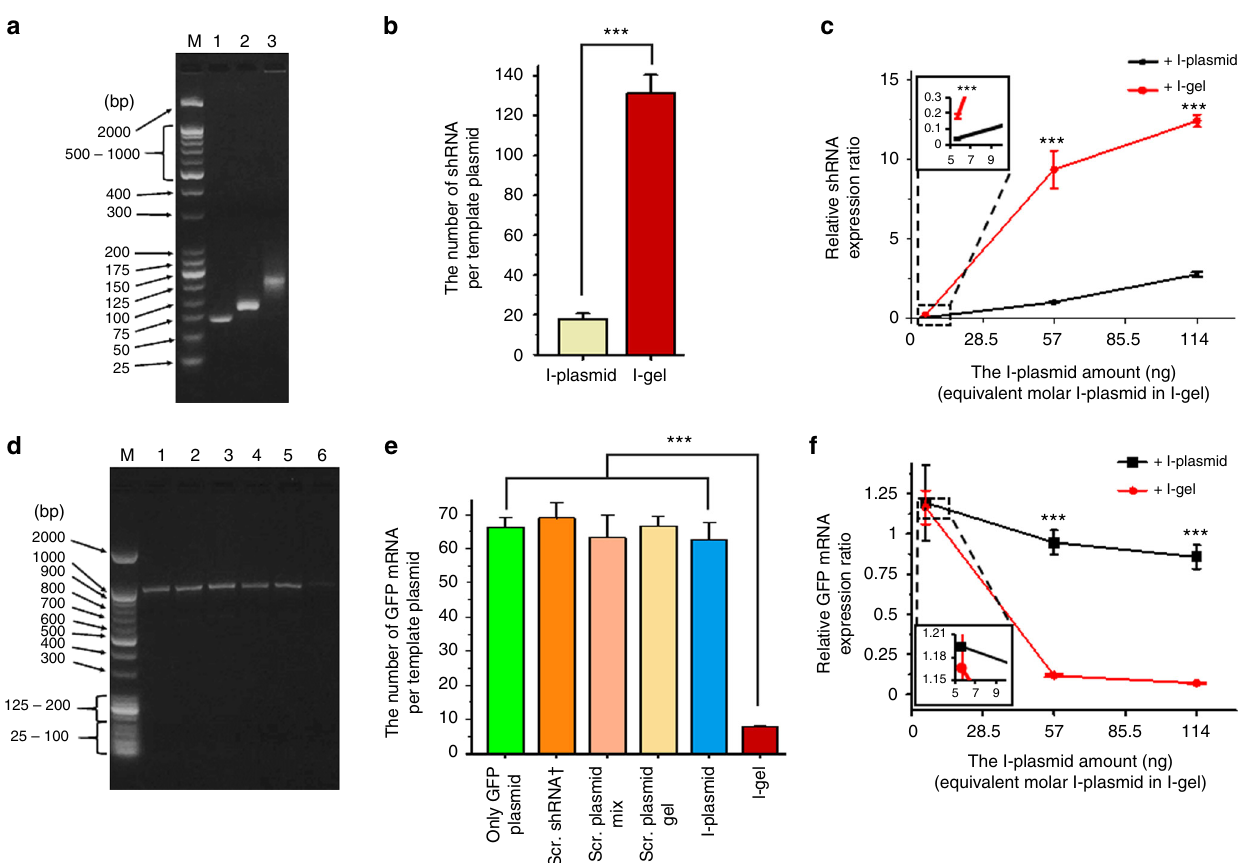
Fig. 3 Comparison of RNA expressions. a , d The RT-PCR products in agarose gel electrophoresis for ( a ) shRNA and ( d ) GFP mRNA detection in extracted RNA samples from the cell lysates. a Samples on gel are lane M: molecular weight standard marker; cDNAs reverse transcribed respectively from Lane 1: standard shRNA, Lane 2: shRNA expressed from I-plasmid, Lane 3: shRNA expressed from I-gel; ( d ) cDNAs reverse transcribed respectively from the GFP mRNAs produced in the cell lysates transcribed/translated in the presence of Lane 1: only GFP plasmid, Lane 2, 3, 4, 5, 6: the addition of scrambled shRNA, scrambled plasmid mixture, scrambled plasmid gel, I-plasmid, and I-gel. b , e Copy number of RNA expressed from a template plasmid for ( b ) shRNA and ( e ) GFP mRNA expression in each condition ( † concentration of scrambled shRNA was 102-fold increased in consideration of the template to RNA transcription rate of the I-gel) ( b ) (*** P < 0.001, analyzed by t test. Asterisks indicate statistically signi fi cant differences between I-plasmid and I-gel) ( e ) (*** P < 0.001, analyzed by t test. Asterisks indicate statistically signi fi cant differences between each condition marked by line and I-gel). c , f The relative RNA expression value for ( c ) shRNA and ( f ) GFP mRNA in 5.7 ng, 57 ng and 114 ng of I-plasmid amount condition. The insets of ( c ) and ( f ) represent zoomed up images of dashed box (*** P < 0.001, analyzed by t test. Asterisks indicate statistically signi fi cant differences between I-plasmid and I-gel). Error bars refer to standard deviations from three